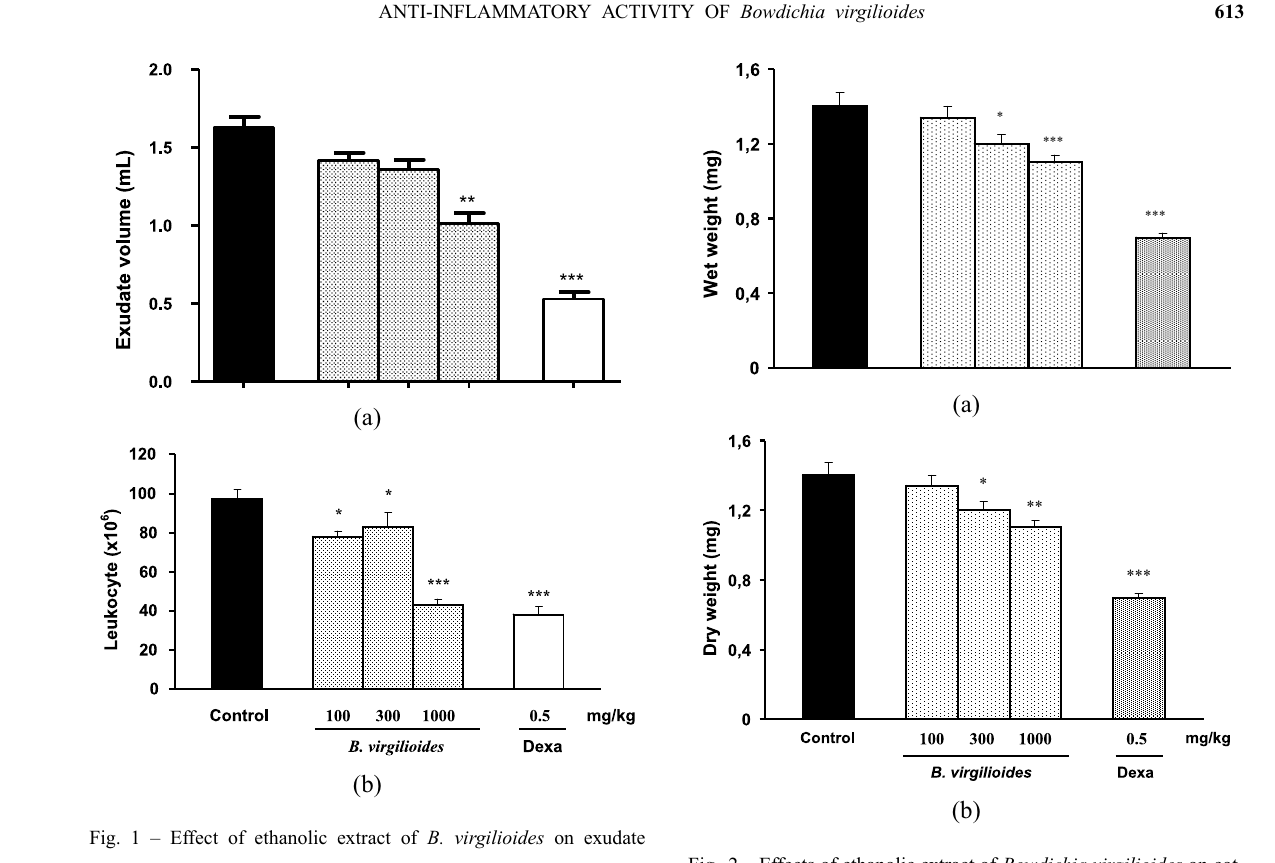
Fig. 2 – Effects of ethanolic extract of Bowdichia virgilioides on cot- ton pellets – induced granuloma (a) wet weight and (b) dry weight in rats. Vehicle, B. virgilioides , 100, 300, 1000 mg/kg and dexametha- sone 0.5 mg/kg. Each column represents the mean ± S.E.M. of 11 animals. *p < 0.05, **p < 0.01, ***p < 0.001. (One-way ANOVA fol- lowed by Student-Newman-Keul’s